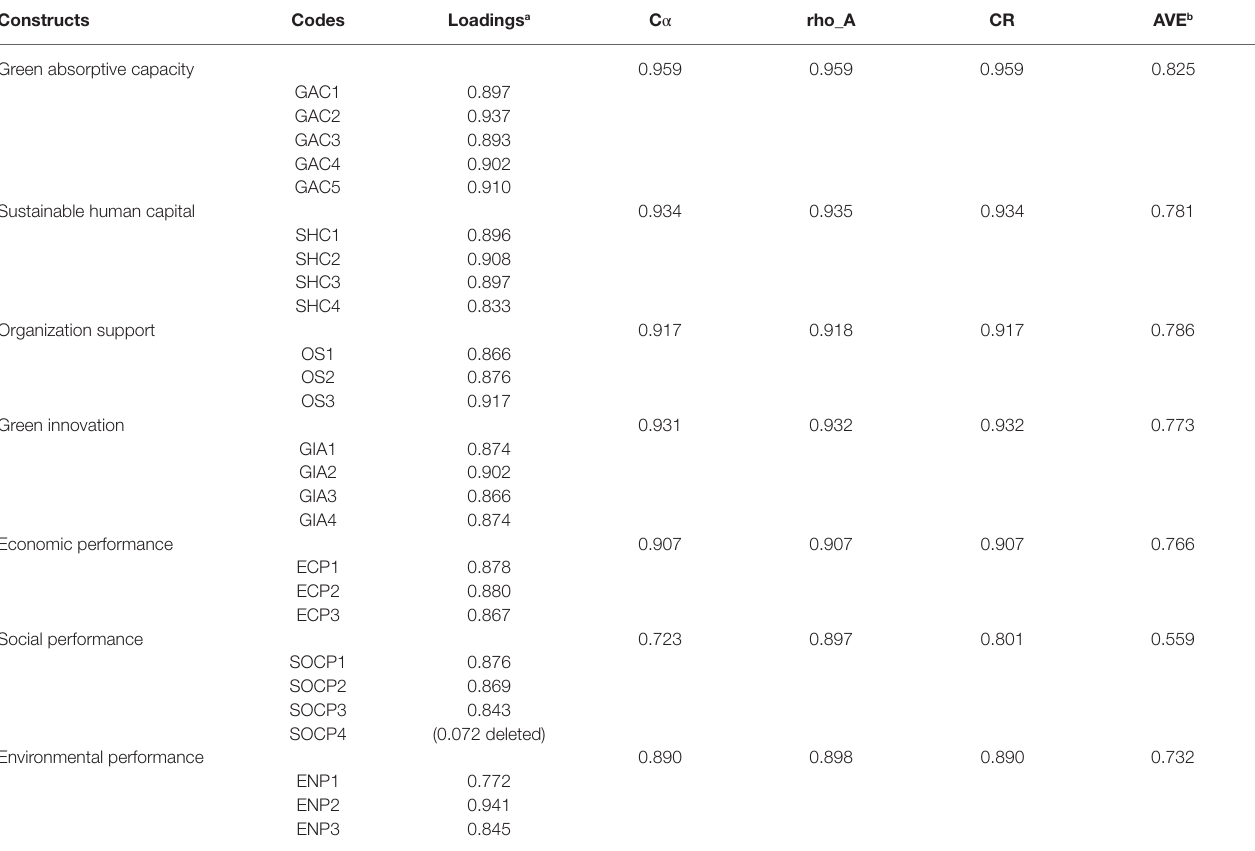
TABLE 2 | Factor loadings, composite reliability, and average variance extracted.